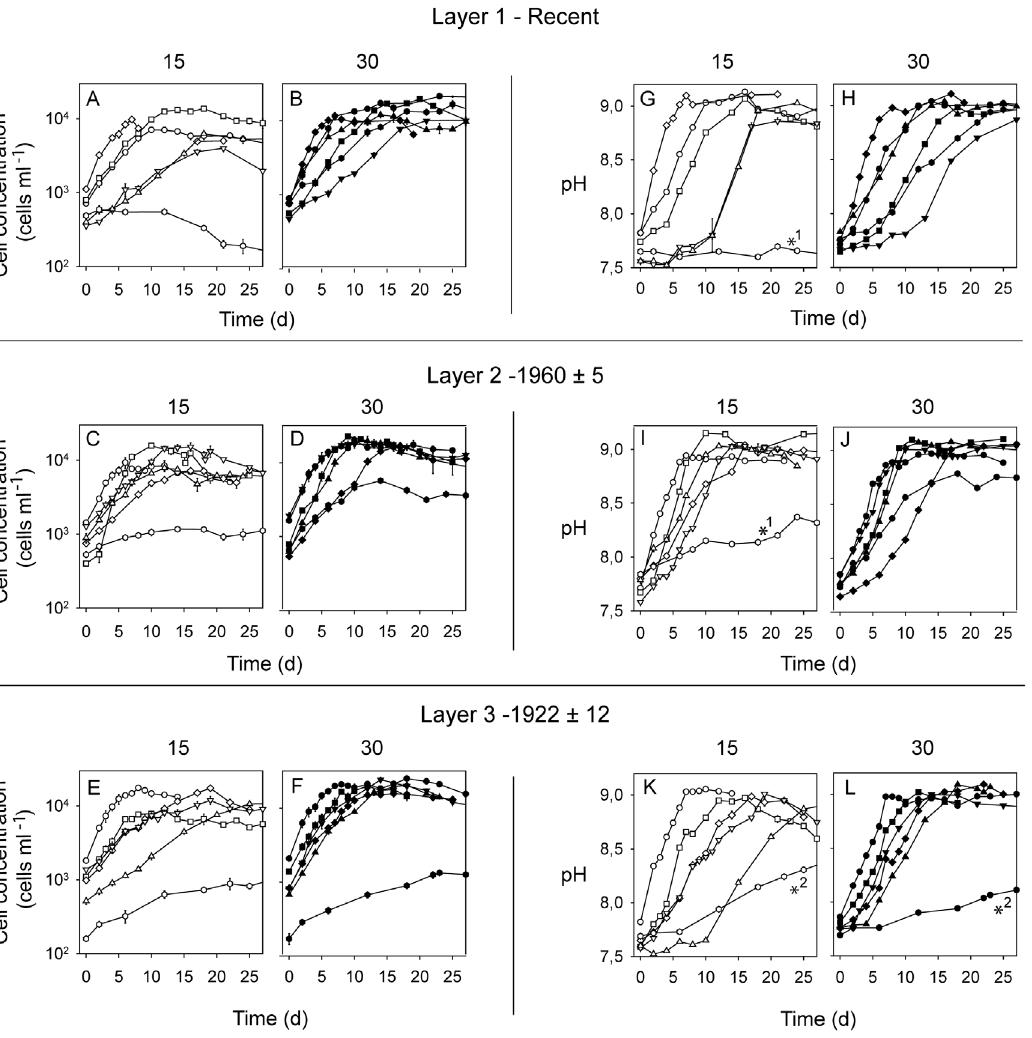
Figure 1. Cell concentration and pH as a function of time. Cell concentrations (A–F) and pH levels (G–L) are shown according to sediment core layer (age-depth) for the 18 Pentapharsodinium dalei strains tested at salinity 15 and 30. Points represent mean values of three replicates and bars represent s.e.m. (standard error of the mean). *1–strains for which upper pH limits could not be determined (see Results section); *2–strain for which upper pH limits were reached after 65